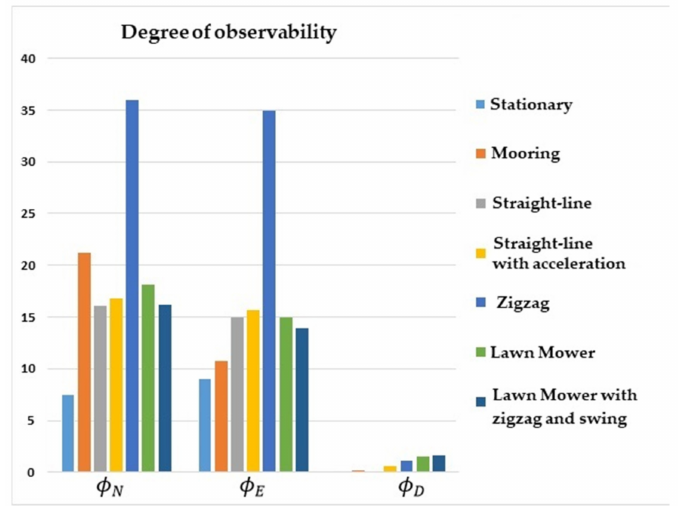
Figure 9. Degrees of observability of the attitude errors. INS/DVL